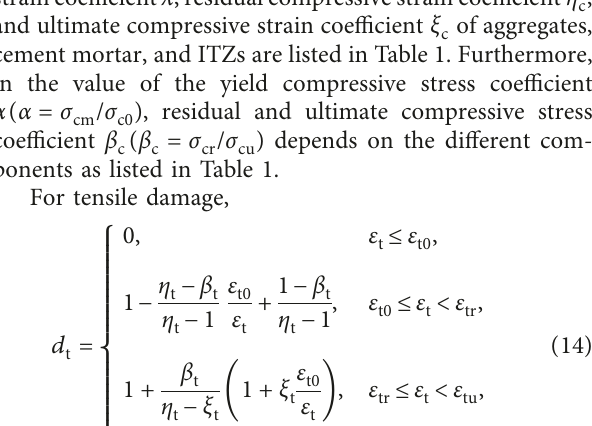
Table 1: Material parameters of concrete mesostructure.